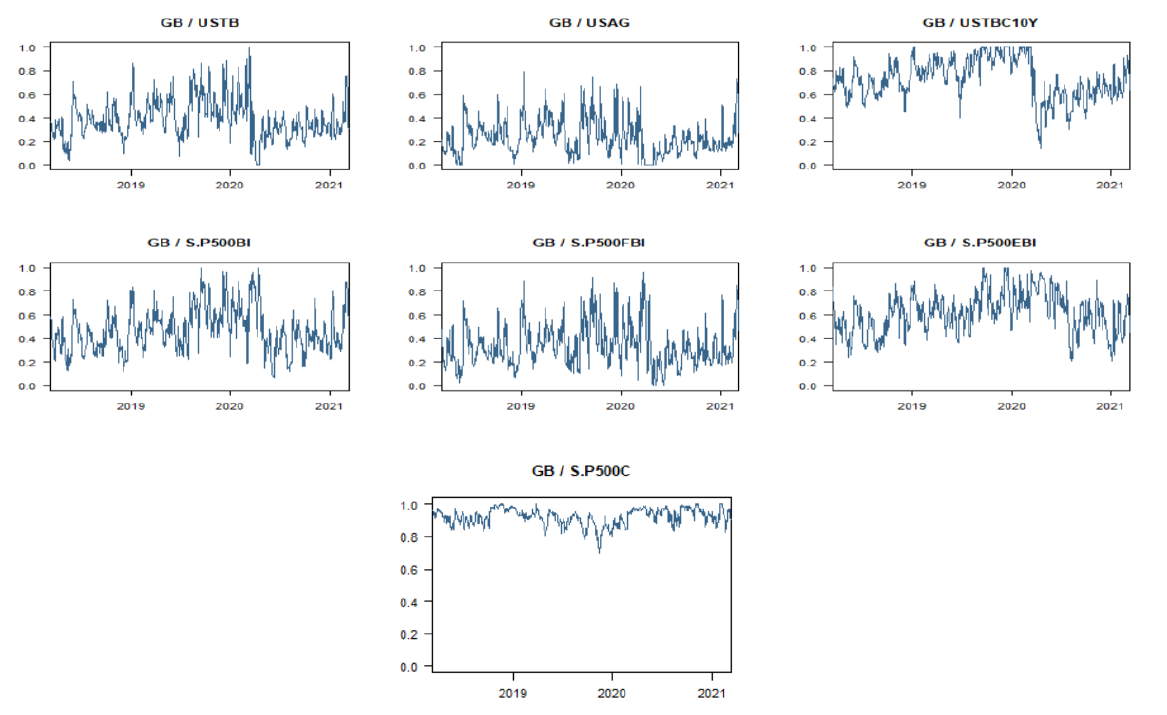
Figure 15. Dynamic Portfolio Weights.